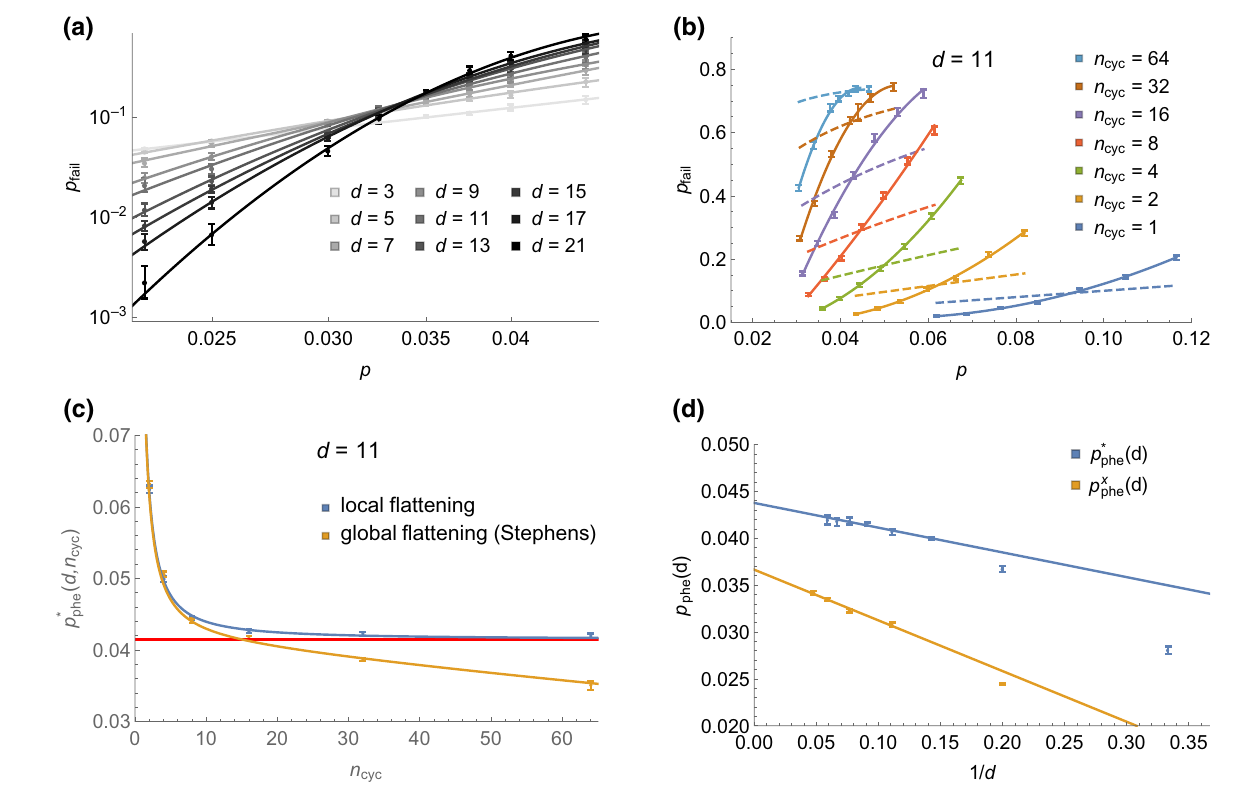
FIG. 12. (a) Failure probability p fail ( d , n cyc ) of the noisy-syndrome projection decoder for n cyc = d time units of phenomenological noise and various distances d . (b) We estimate the time-dependent pseudothreshold p ∗ with the error probability for the unencoded qubit (dashed) after n cyc time units for various n cyc and d = 11. See Appendix B for the analysis of other distances. (c) We estimate the long-time pseudothreshold p ∗ with the numerical ansatz in Eq. (11). Note that Stephens’ adaptation of the decoder (yellow), which uses a global flattening, fails to stabilize. (d) The long-time pseudothresholds p ∗ to distances d and ( d + 1 )/ 2 for various d . From a linear extrapolation of the data for d ≥ 7 we obtain intercepts of 4.38(3)%